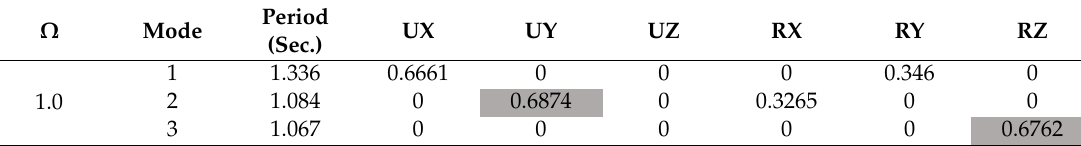
Table 10. Modal Participating Mass Ratio Buildings (with b / r = 2.45, 1 < Ty < 2 s, Ω =